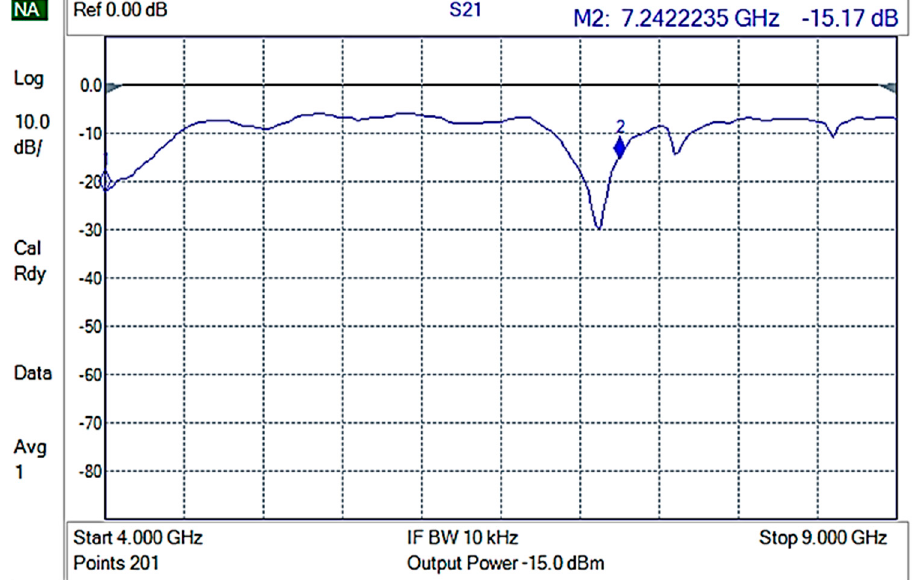
Figure 7. S21 for the empty holder (reference).